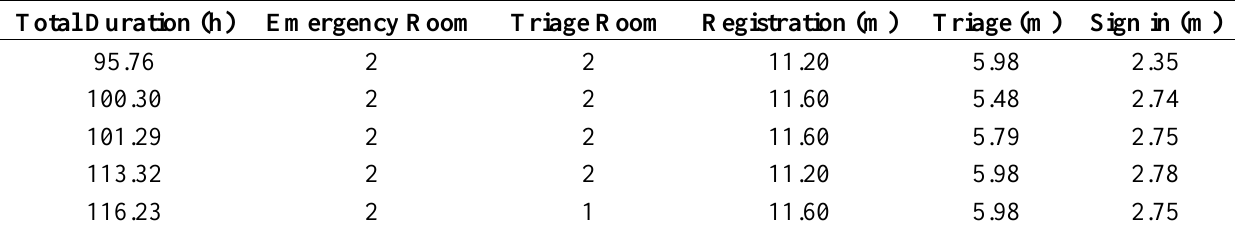
Table 13. KPI along generations during the maximization phase.